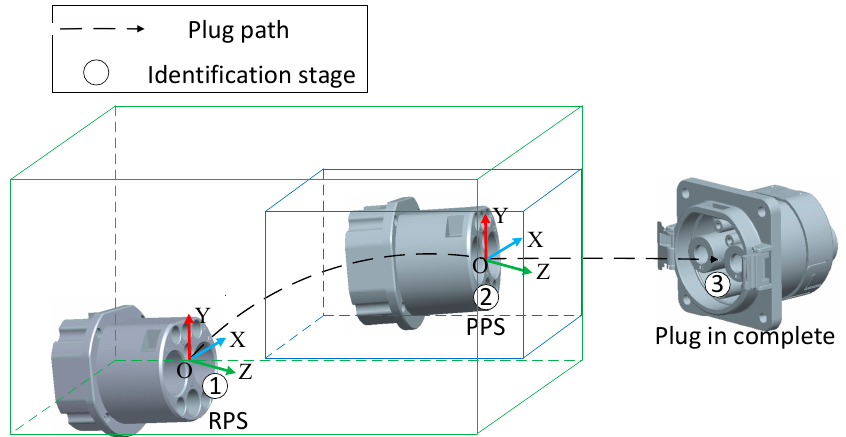
Figure 2. Schematic diagram of identification stage scope.